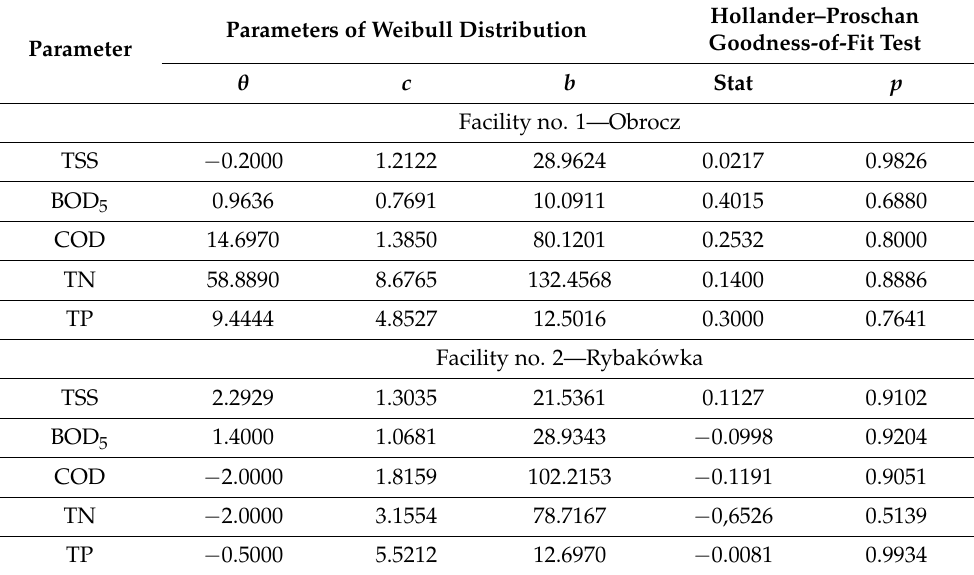
Table 4. Parameters of the Weibull distribution and the Hollander–Proschan goodness-of-fit test ( n =